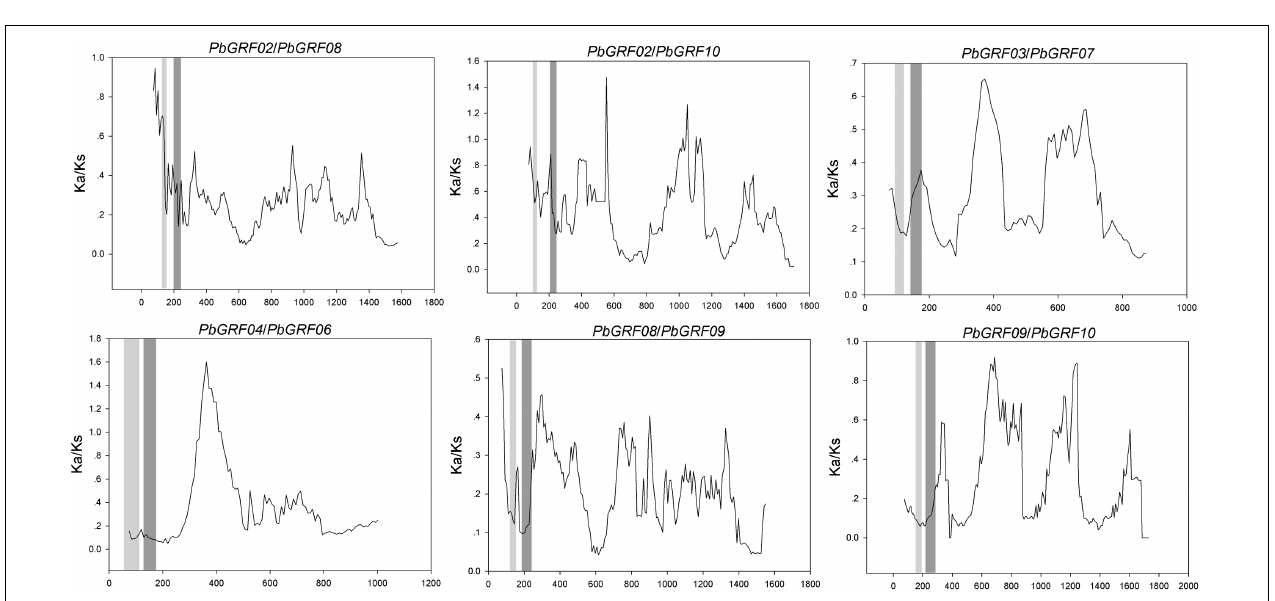
FIGURE 7 | Scatter plots of the Ka/Ks ratios of duplicated GRF genes in pear, Populus , grape, Arabidopsis and rice. The X - and Y -axes denote the synonymous distance and Ka/Ks for each pair, respectively.